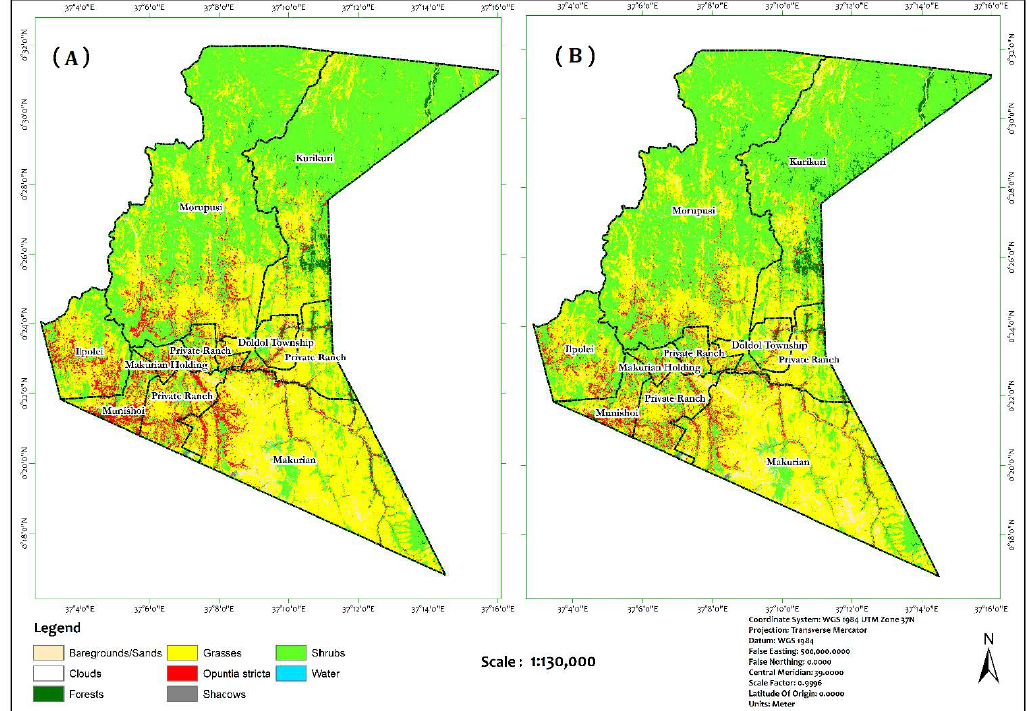
Figure 5. Maps showing the classification results of model 2.a and model 2.b are XGBoost and RF, respectively, with vegetation and topographic indices added to the Sentinel-2 reflectance bands, panel ( A , B ), respectively. The boundaries present the different land tenures present within the study area.